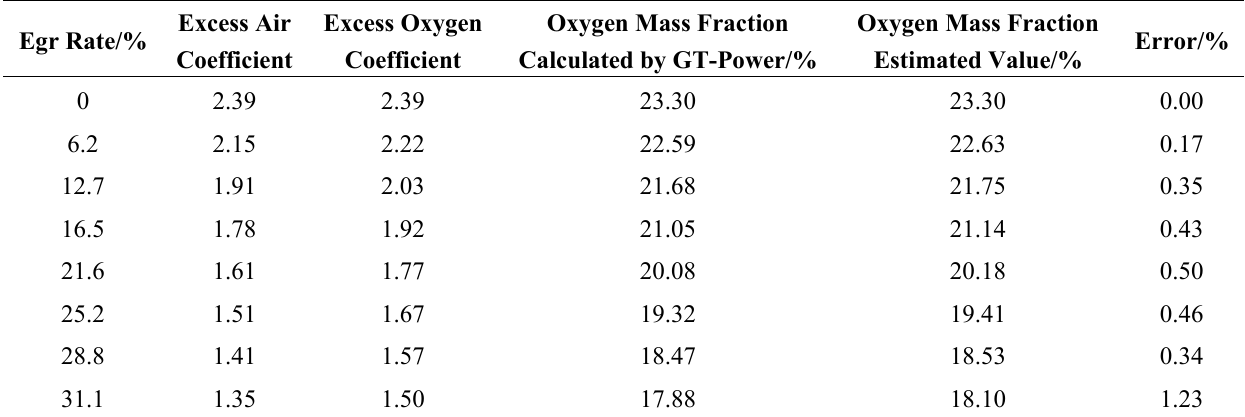
Table 2. Calculated oxygen mass fraction